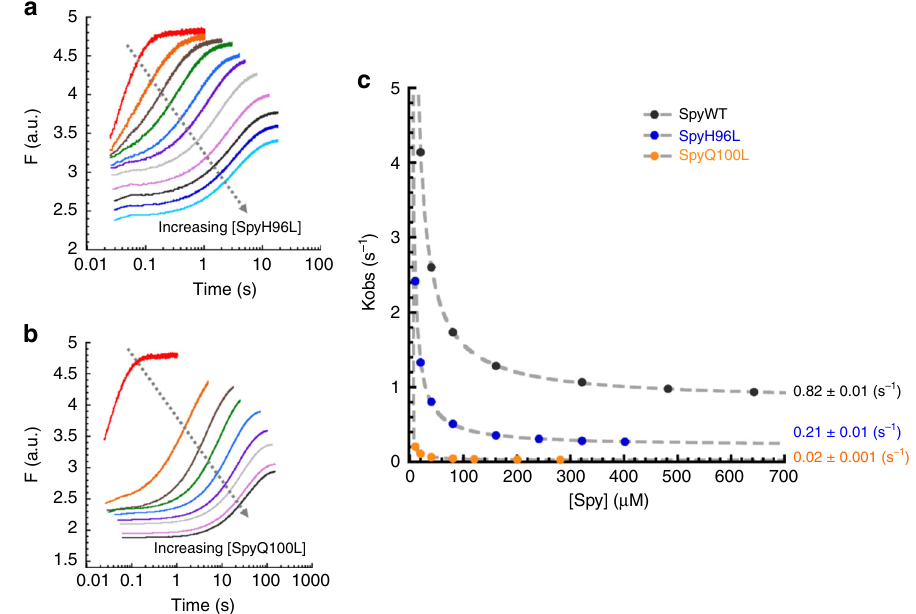
Fig. 4 The kinetics of SH3 folding in the presence of SpyH96L and SpyQ100L. a The fl uorescence traces for SH3 refolding in the presence of various concentrations of SpyH96L (0 – 402 μ M dimer after mixing). b The fl uorescence traces for SH3 refolding in the presence of various concentrations of SpyQ100L (0 – 281 μ M dimer after mixing). All the traces in a and b can be described by a single exponential function. c Plot of k obs for SH3 folding as a function of the concentrations of Spy variants (H96L in blue and Q100L in orange). The k obs hyperbolically decreased with increasing concentrations of the Spy variants, reaching a limiting value that is signi fi cantly lower than that of wild-type Spy (black). The saturating value of k obs was 0.21 s − 1 for SpyH96L and 0.02 s − 1 for SpyQ100L, whereas the value for wild-type Spy was 0.82 s − 1 . Experimental conditions were exactly the same as in Fig.